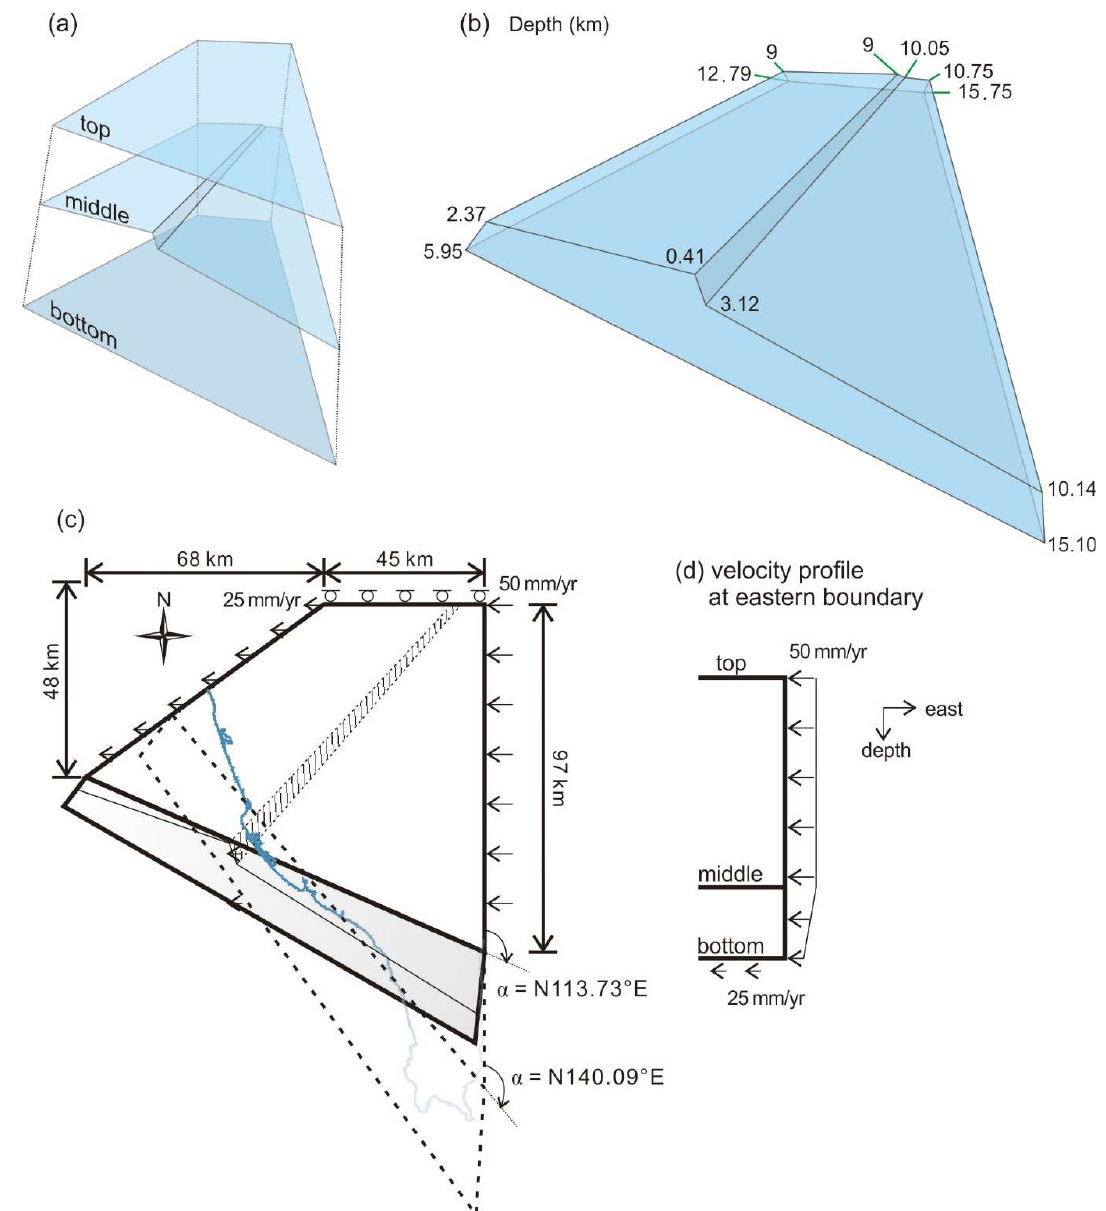
Figure 3. Model settings. ( a ) The model is composed of two material layers and three lateral surfaces. ( b ) The depth of the surface intersections in the initial mesh. ( c ) A 3D perspective drawing of the two geometries in this study and the velocity boundary condition. ( d ) The velocity boundary condition at the eastern boundary.